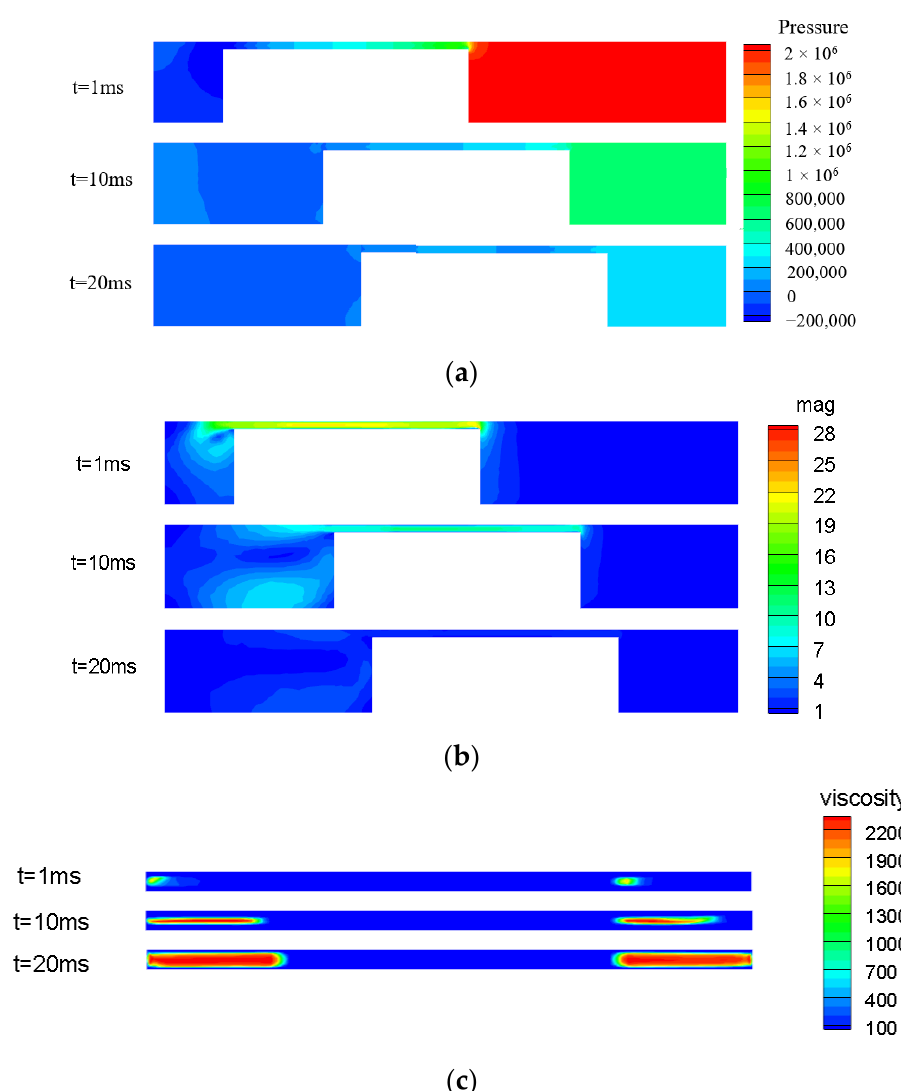
Figure 14. Pressure, velocity and viscosity contours at different times under impact conditions. ( a ) Pressure contours; ( b ) velocity contours; ( c ) viscosity contours.